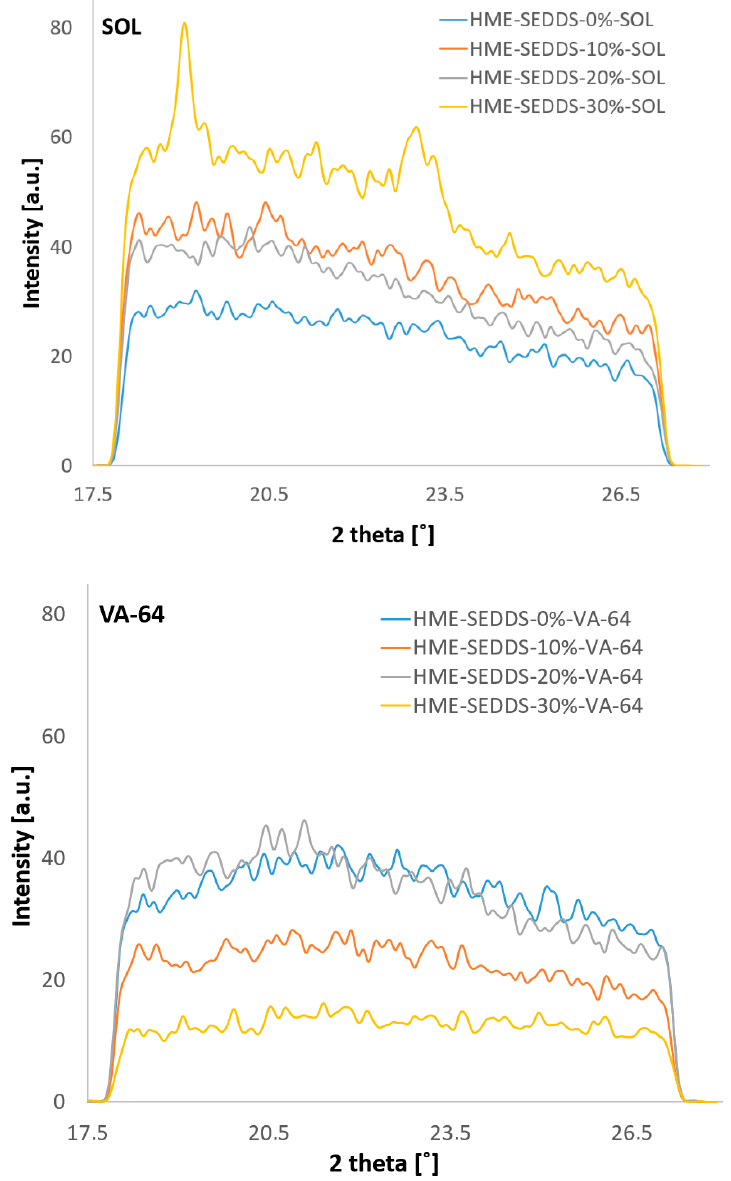
Figure 5. WAXS profiles of HME–SEDDSs–SOL and HME–SEDDSs–VA-64 formulations.